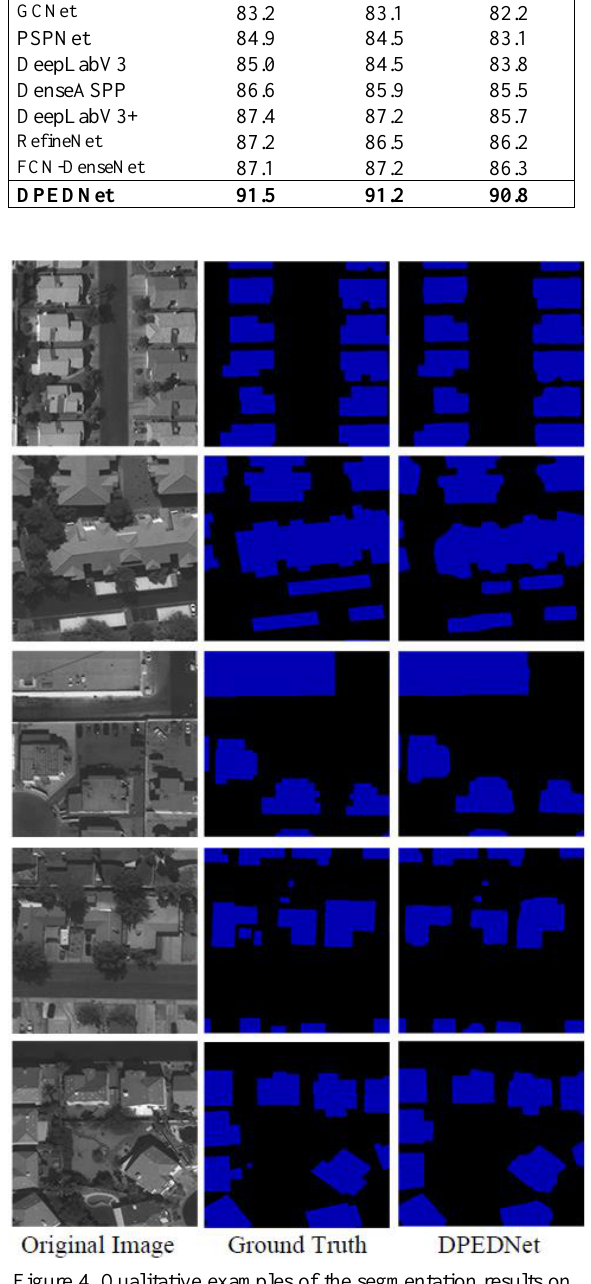
Figure 4. Qualitative examples of the segmentation results on Crowed mapping challenge dataset with single channel